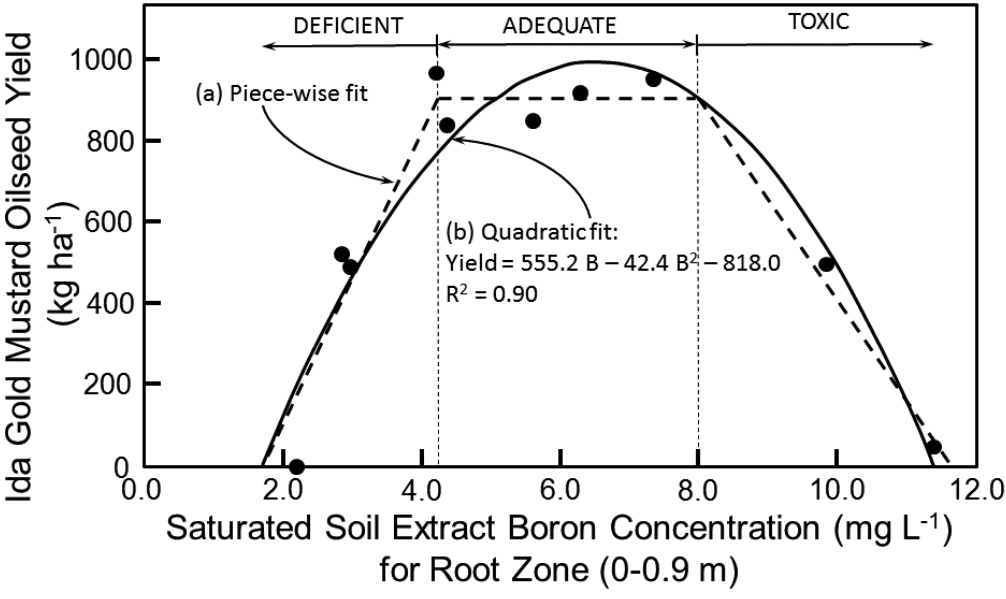
Figure 6. Boron tolerance models for Ida Gold mustard oilseed: ( a ) three-piece linear B tolerance model (thick dashed line) and ( b ) quadratic B tolerance model (solid line). Thin dashed lines indicate the B deficiency and toxicity thresholds.